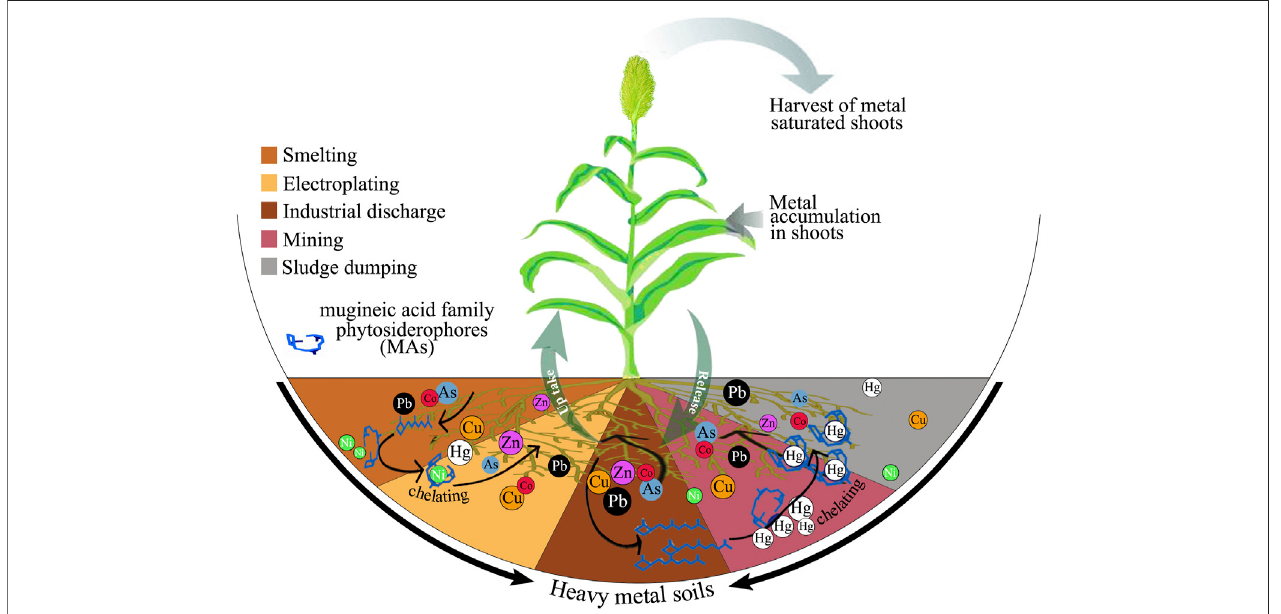
FIGURE 2 | The process of heavy metals accumulation in giant